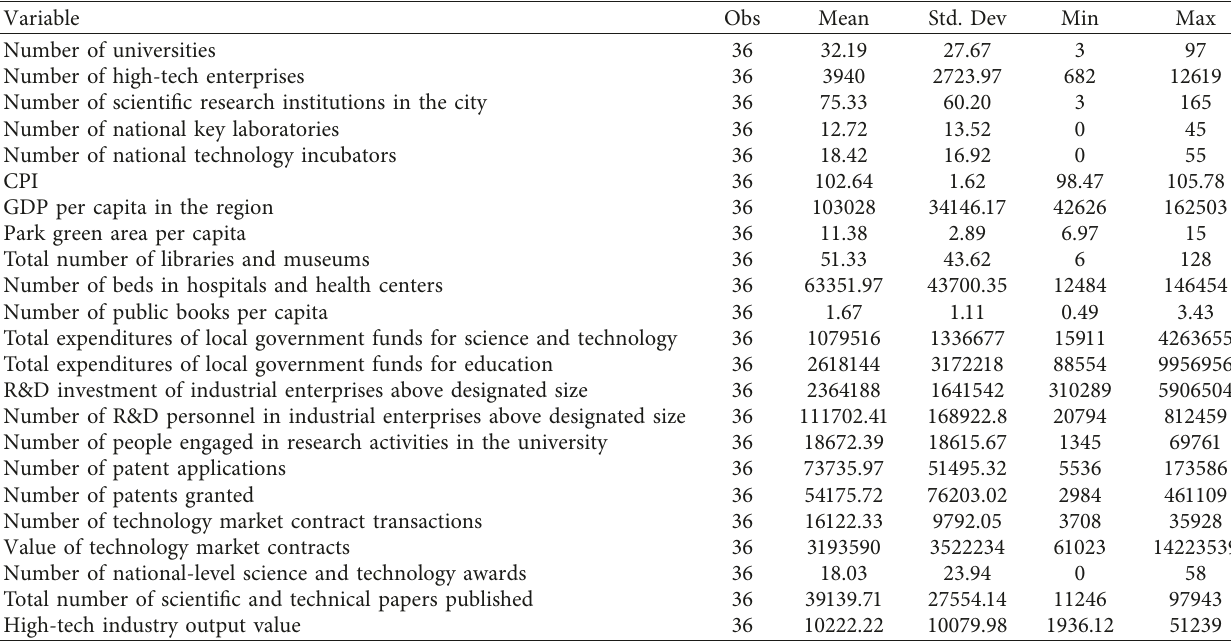
Table 4: The descriptive statistics of all indicator